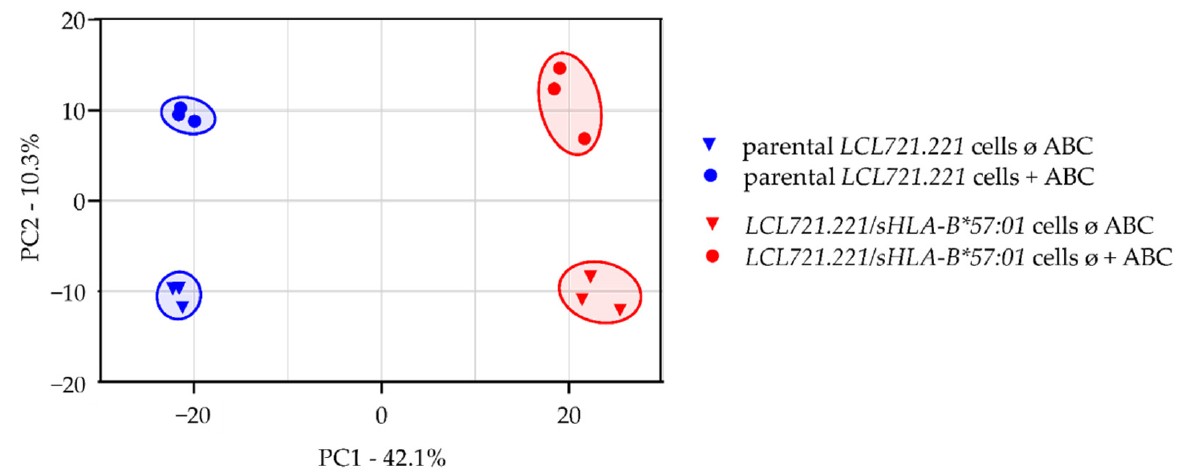
Figure 3. Principal component analysis (PCA) of proteins that were significantly altered ( p < 0.05) in parental LCL721.221 cells (blue) and LCL721.221/sHLA-B*57:01 cells (red) without ABC treatment (circle) and following ABC treatment (triangle). Cells were incubated without (ø) or with (+) ABC for 48 h in three technically independent replicates ( n = 3).